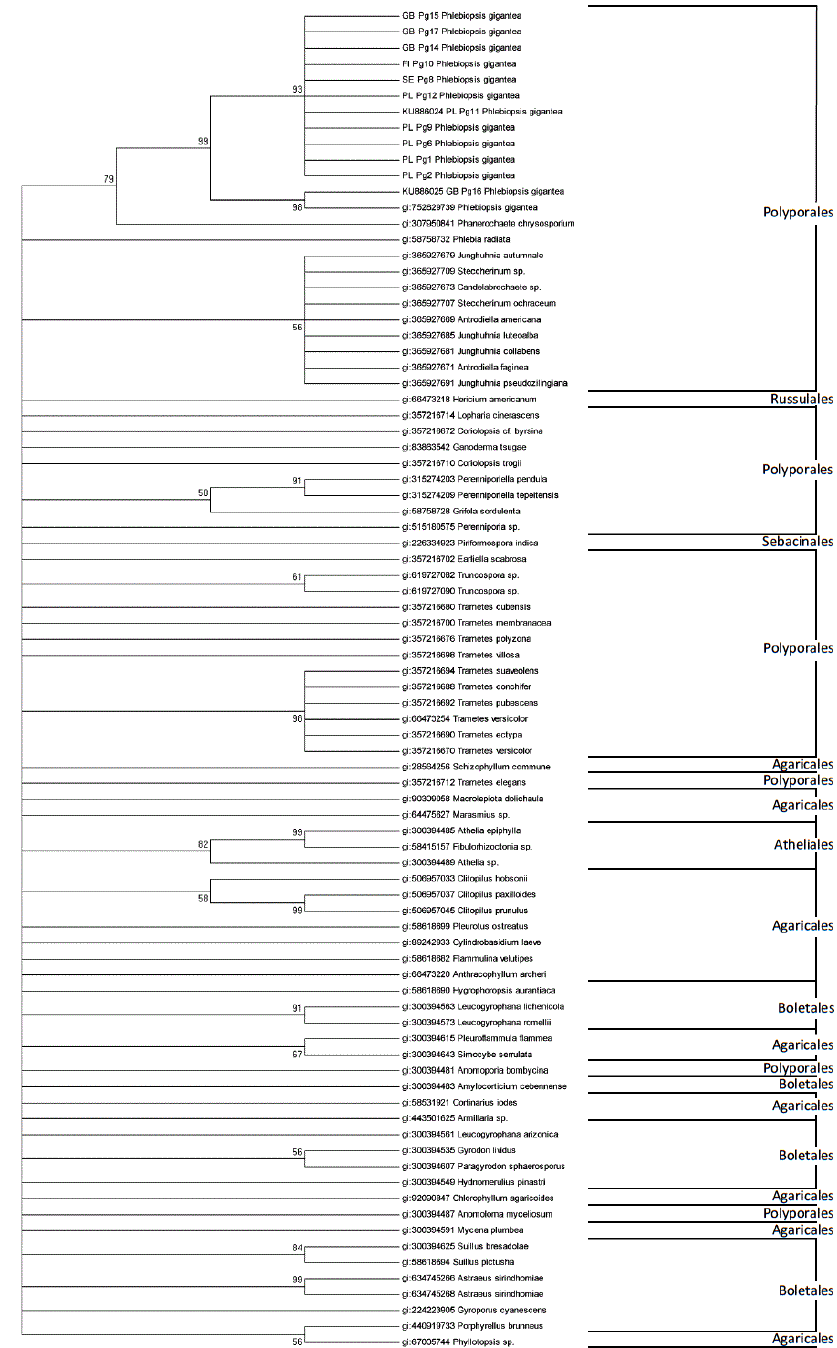
Figure 3. Phylogenetic tree for Phlebiopsis gigantea isolates and selected Basidiomycota , based on the EF1α partial gene sequences. The tree was reconstructed using the maximum likelihood approach and tested by bootstrapping (1,000 replicates).